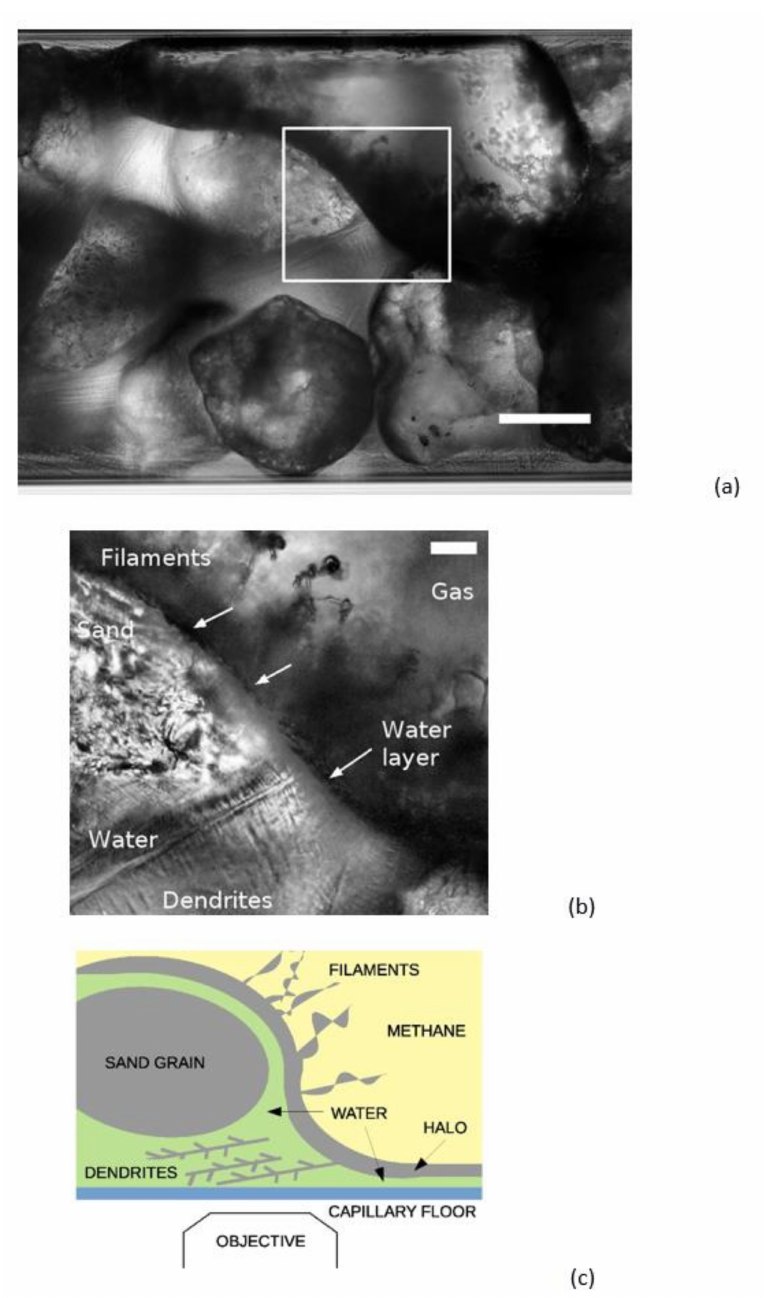
Figure 11. Section through a gas-water-sand interface ( a ) General, showing abrasion of the sand grains and a meniscus separating interstitial water in capillary bridges (lower left) from the gas (upper right); ( b ) Zoomed view of the boxed region in ( a ). With the focus being neither on the glass nor on a sand grain, but in a plane in the bulk of the water, the hatched hydrate growth (lower left) is dendritic; filaments sprout into the gas on the other side, cf. Figure 6. The section shows a water layer surrounding the grain of sand. ( c ) Schematic view of ( b ). Scale bars: ( a ) 100 µ m, ( b ) 20 µ